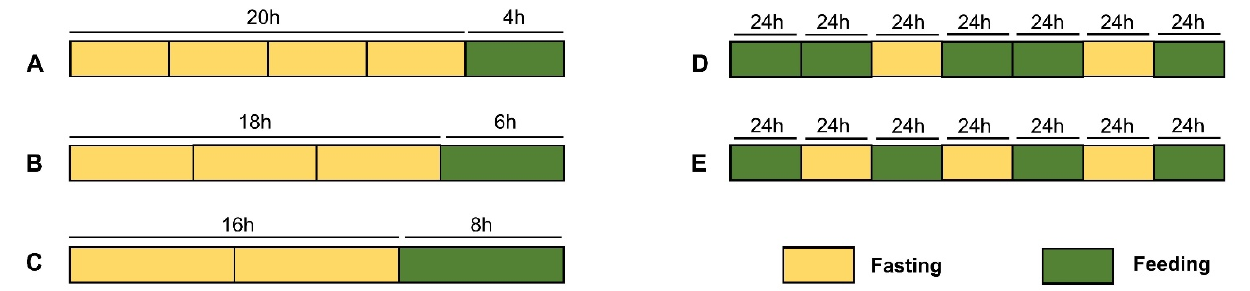
Figure 1. Patterns of intermittent fasting. ( A – C ) Time ‐ restricted eating: 16 h fast followed by an 8 h eating period ( A ); 18 h fast followed by a 6 h eating period ( B ); 20 h fast followed by a 4 h eating period ( C ). ( D , E ) Alternate 24 h fasting with 24 h eating: eating for 5 days of the week and fasting for 2 days ( D ); eating for 4 days of the week and fasting for 3 days ( E ).